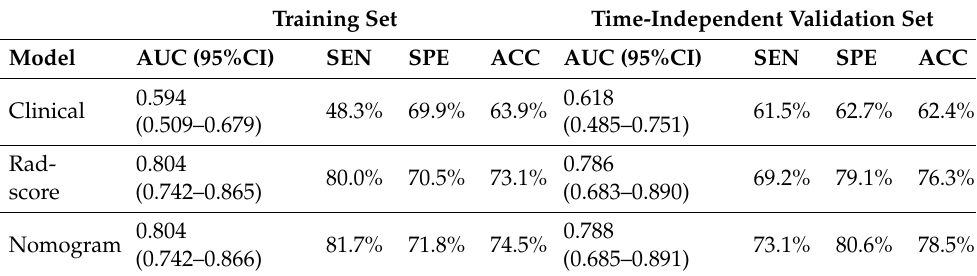
Table 7. Predictive performances of the models identifying HER2+ status in patients with BC. Training Set